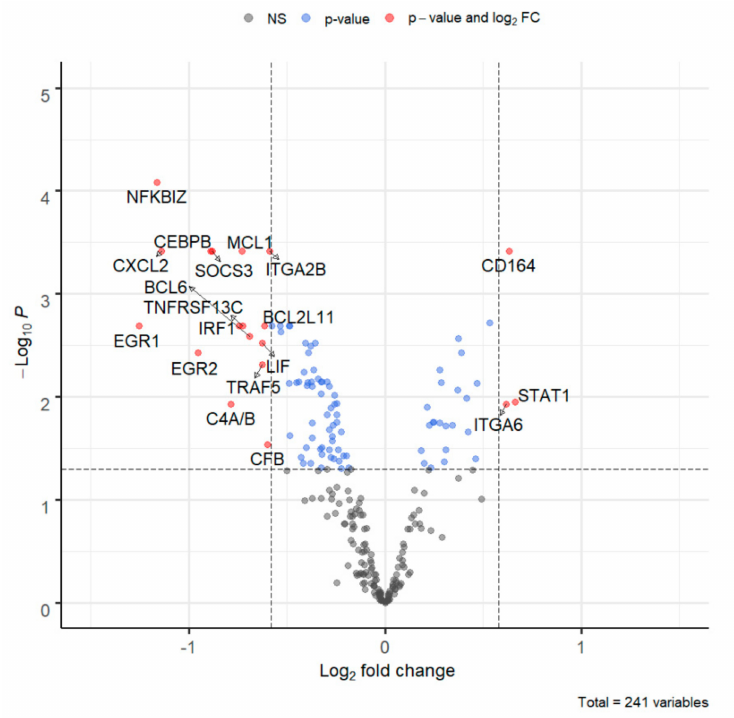
Figure 3. Volcano plot. Log 2 fold change and − log 10 of the adjusted p -value of the differential expression analysis were plotted. The horizontal line represents the adjusted p -value of 0.05. Vertical lines correspond to − 0.58 and 0.58 log 2 fold changes, which are equivalent to the − 1.5 and 1.5 linear fold changes, respectively. Blue dots are differentially expressed genes; red dots are the genes differentially expressed with an absolute value of log 2 fold change greater than